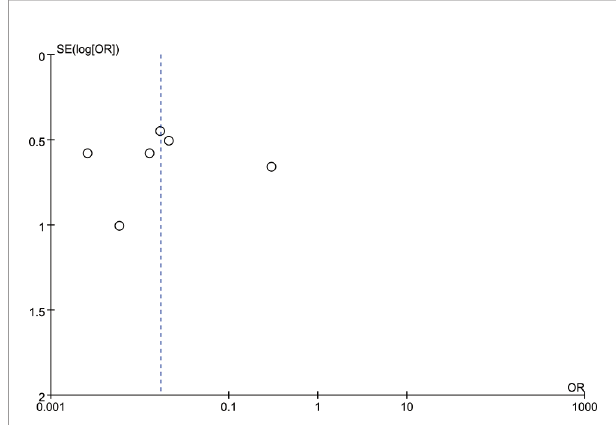
FIGURE 3 | The funnel plot indicated a trend in publication bias. The dotted line is provided as a reference to the composite estimate from the combined